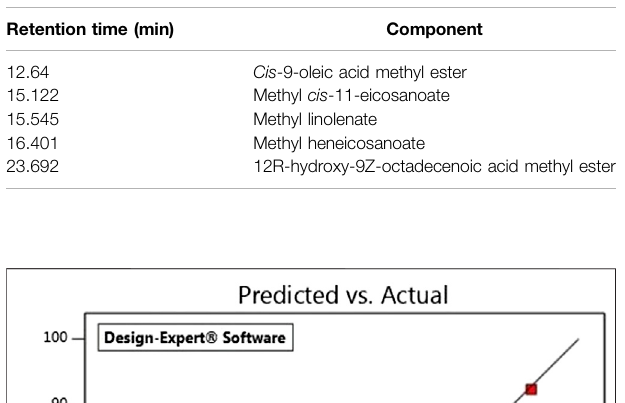
TABLE 3 | Fatty acid compositional pro fi le of castor